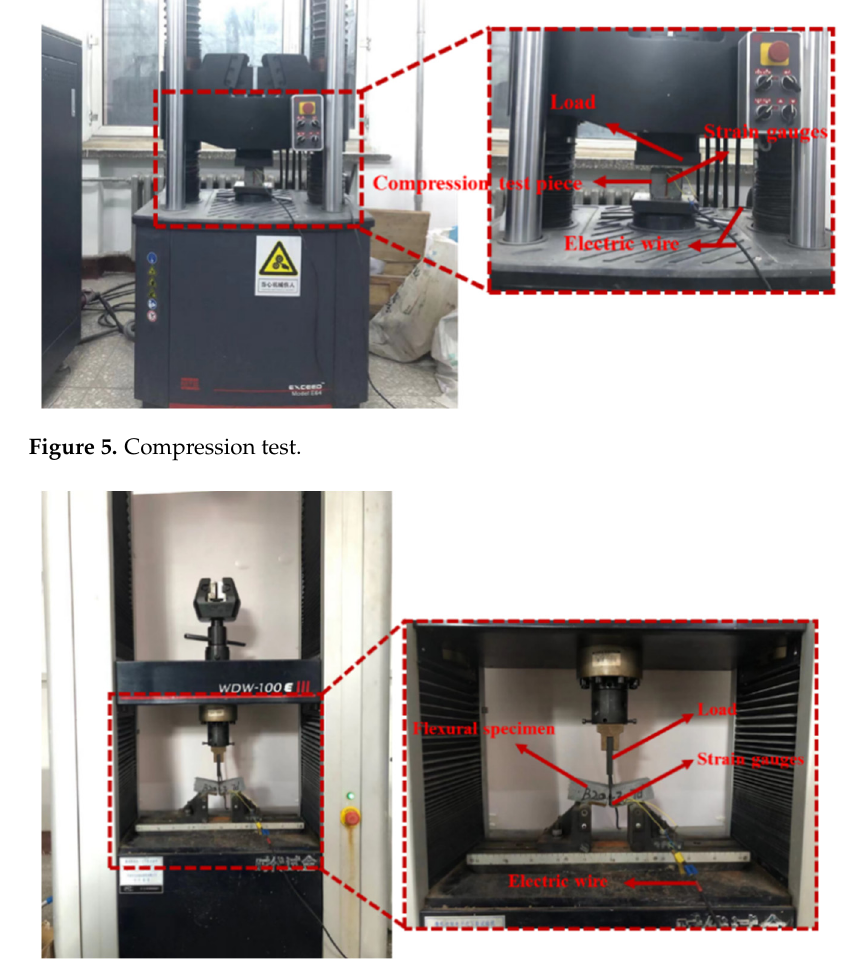
Figure 6. Flexural test.